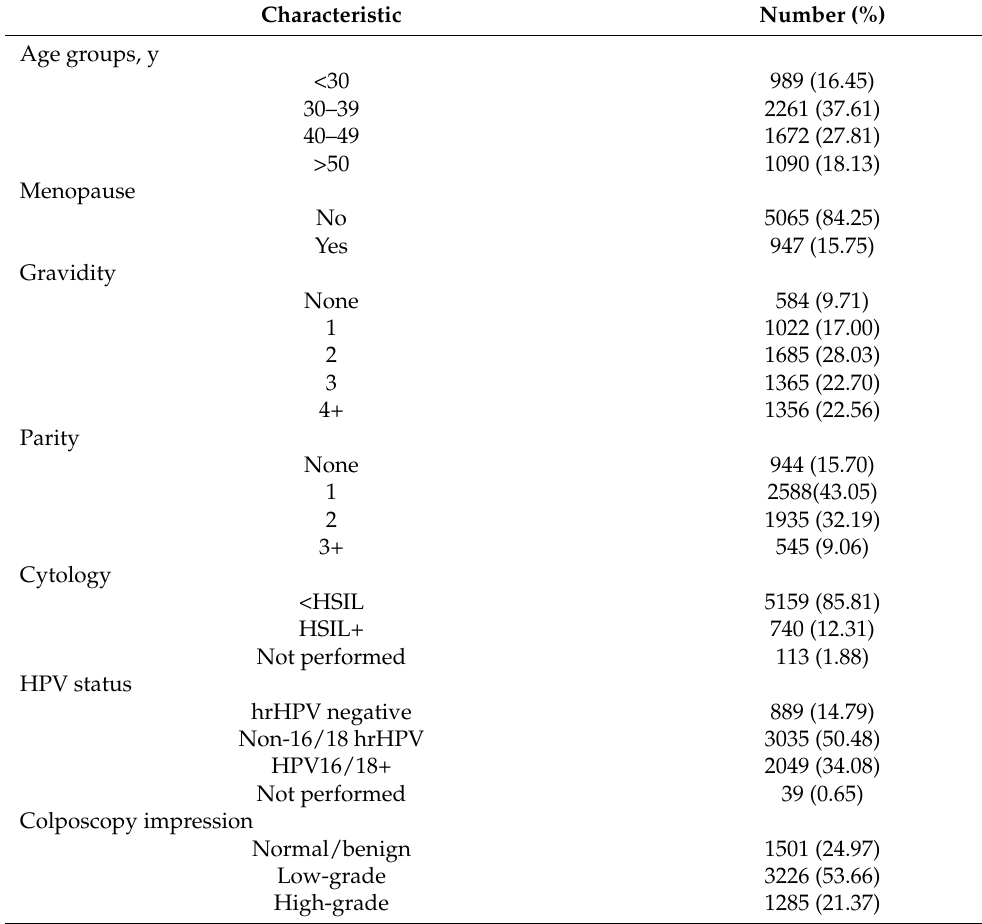
Table 1. Baseline demographic and clinical